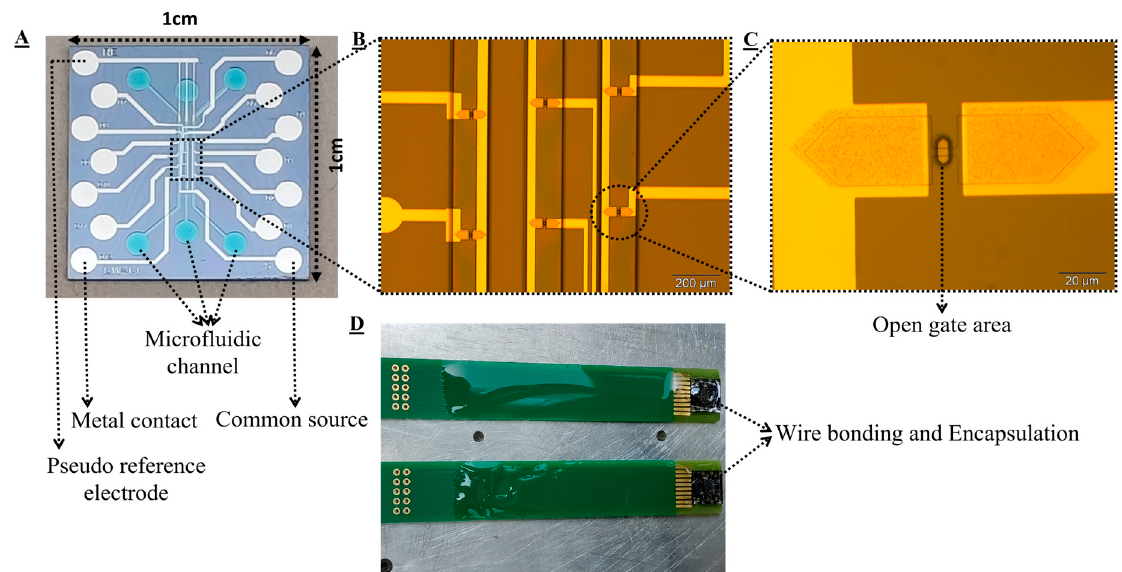
Figure 3. Fabricated chip design and encapsulation. ( A ) image of the single chip, ( B ) SU-8 channels, ( C ) gate opening of a single FET in a thin SU-8 layer. Color change is observed at doped source and drain regions due to the formation of a PtSi alloy, and ( D ) encapsulation with epoxy glue.